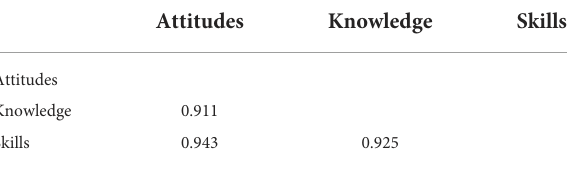
TABLE 2 HTMT criterion showing the discriminant validity among the constructs.